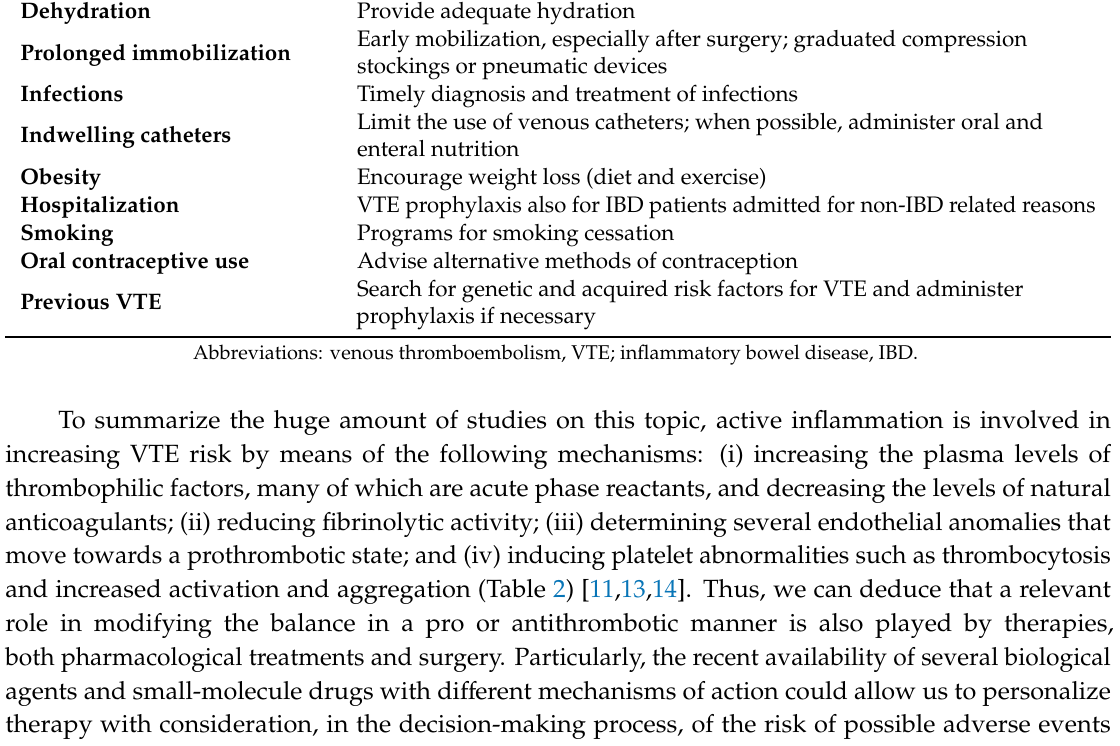
Table 1. Acquired risk factors for VTE in IBD patients and modalities for their prevention and / or treatment. Risk Factor Prevention / Treatment Modality Hyperhomocysteinemia Correction of vitamin deficiency (vitamin B12, vitamin B6, and folic acid) Dehydration Provide adequate hydration Early mobilization, especially after surgery; graduated